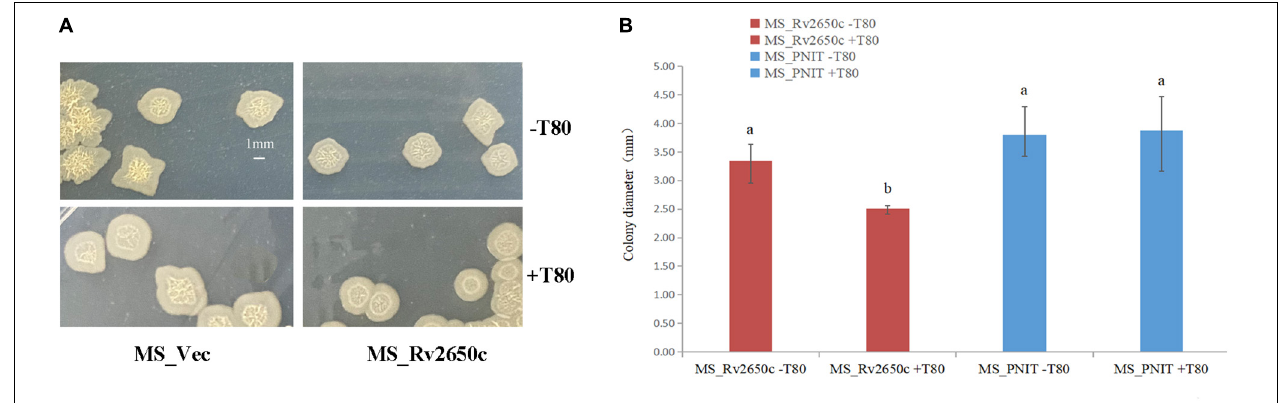
FIGURE 2 | Comparison of the structure of cellular aggregation about the recombinant M. smegmatis MS_Rv2650c and MS_Vec. (A) MS_Rv2650c and MS_Vec strains were inoculated on MB 7H9 plates with or without 0.05% (v/v) Tween 80 and cultured at 37 ◦ C for 5–6 days. (B) The diameter of a single colony was observed and counted. Significantly differences ( P < 0.05) are represented by different